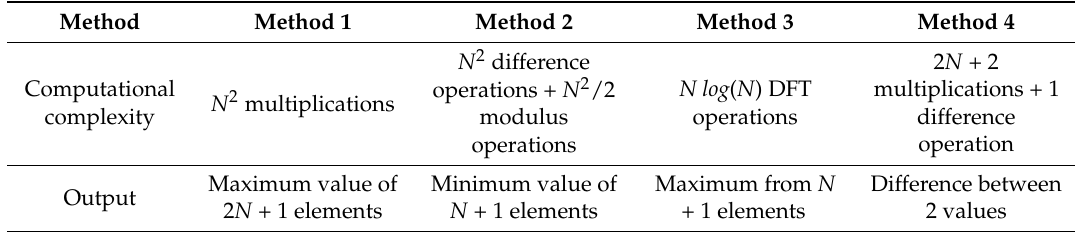
Table 1. Computational complexity and output of the selected four methods ( N = sample size).